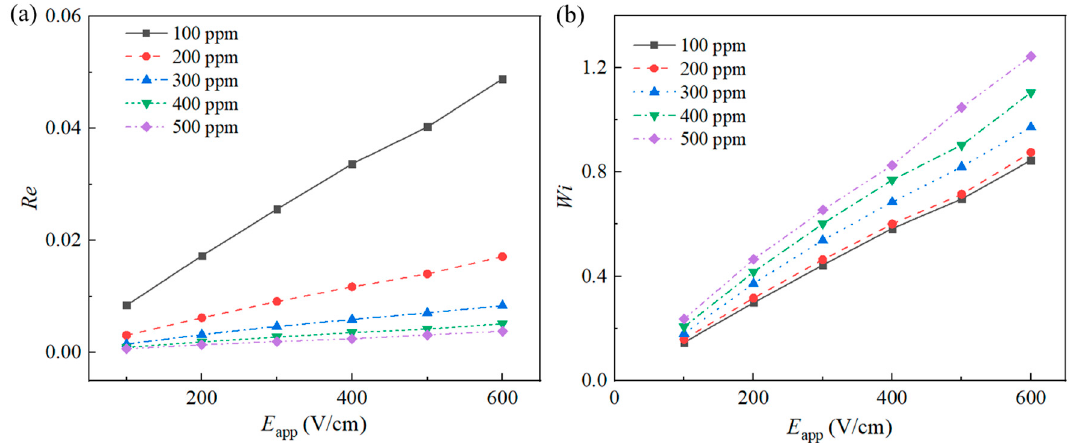
Figure A8. Reynolds number ( a ) and Weissenberg number ( b ) of the viscoelastic EOF under the conditions of Figure 15.